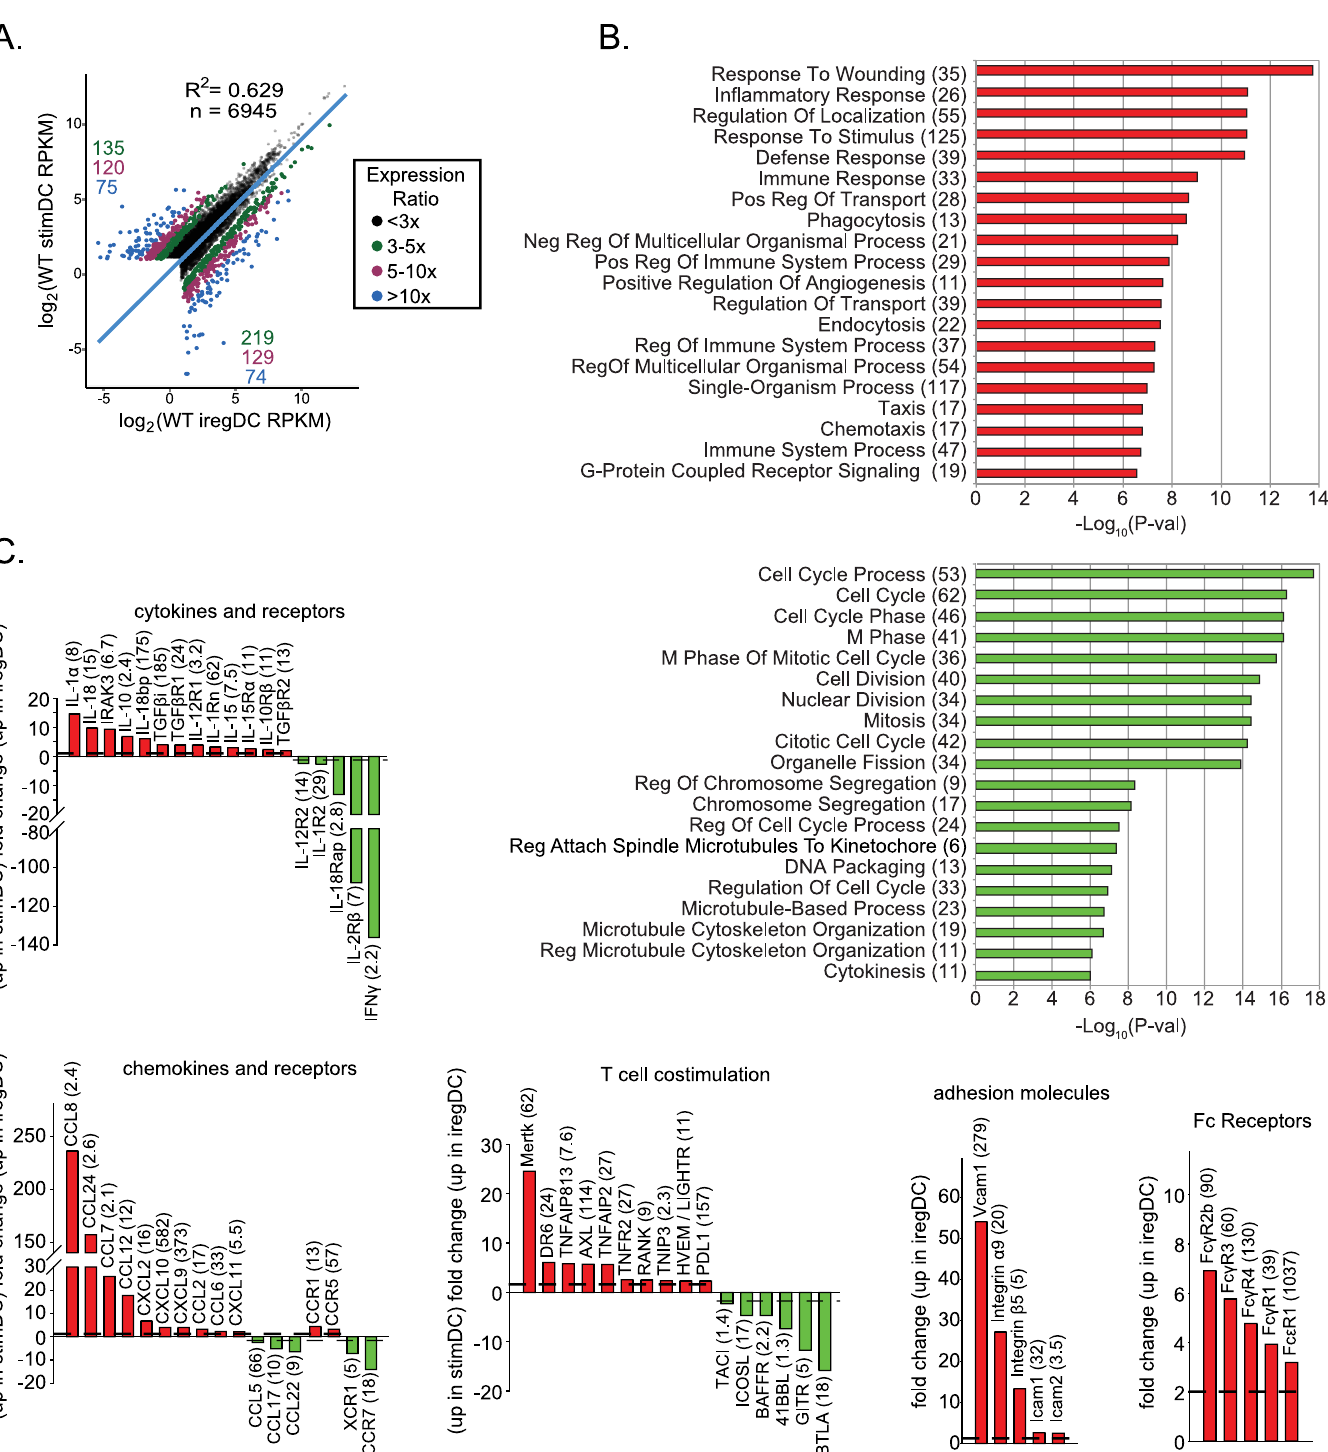
PLOS Pathogens | DOI:10.1371/journal.ppat.1005356 January 25,